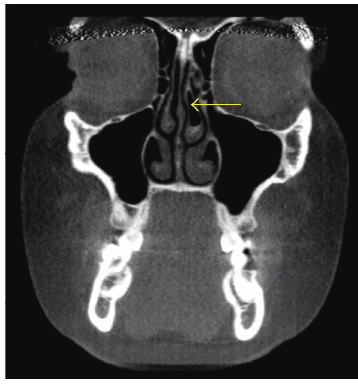
Figure 1: Coronal CT scan demonstrating the presence of left middle concha bullosa (arrow). No septal deviation or sinusitis is present. Note the size di ff erence in the middle conchae, with the left middle concha larger than the right middle concha.